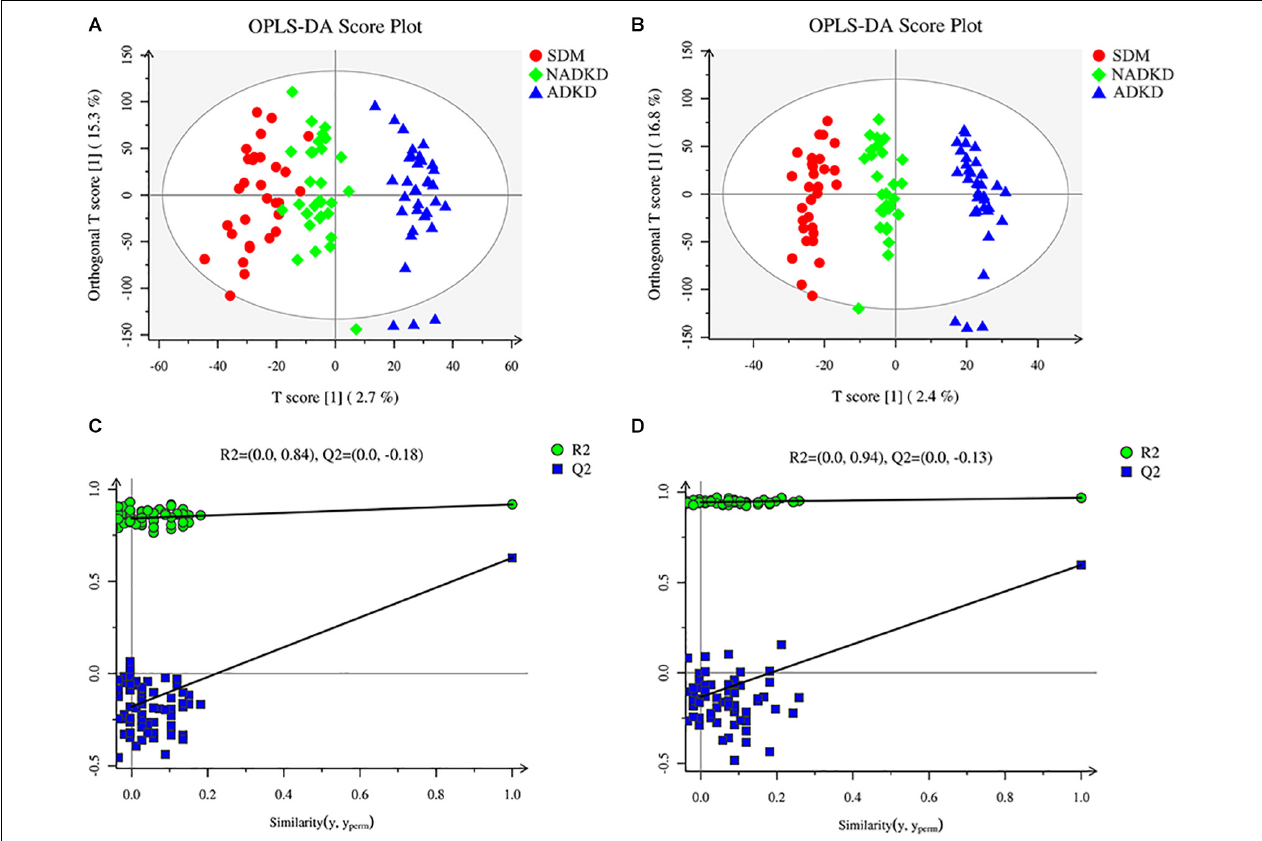
FIGURE 2 | Plots of OPLS-DA score and permutation test. (A) OPLS-DA score plot in positive ion mode. (B) OPLS-DA score plot in negative ion mode. (C) OPLS-DA permutation test plot in positive ion mode. (D) OPLS-DA permutation test plot in negative ion mode. The criterion for evaluating whether there is overfitting in the OPLS-DA model is that the regression line at a blue Q2 point crosses or is less than 0 from the